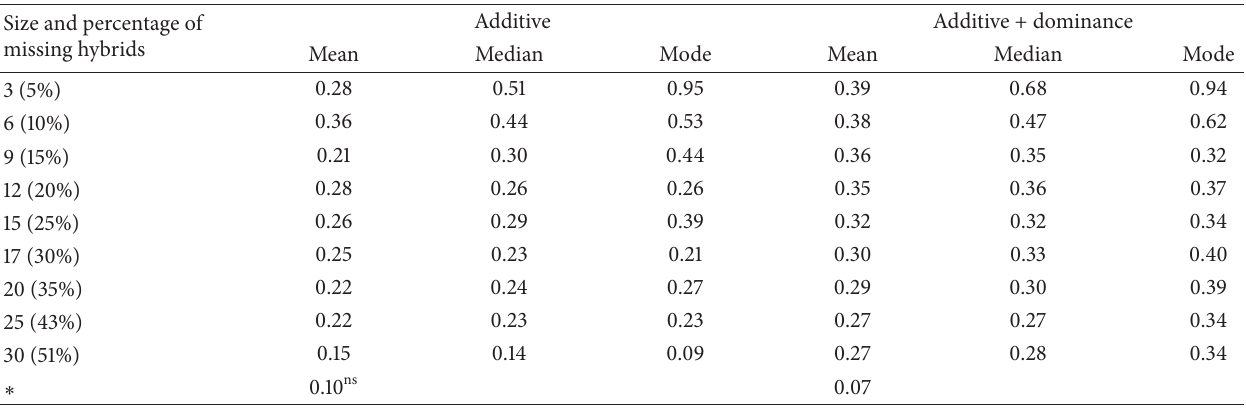
Table 2: Means, medians, and modes of the correlations between the predicted values of untested hybrids and the outcomes of the test population, using different sample sizes of disequilibrium in both the additive and additive + dominance models.